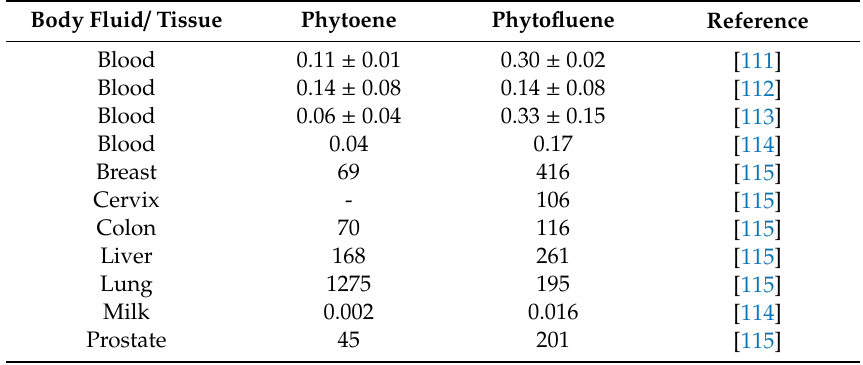
Table 3. Concentration of phytoene and phytofluene in body fluids ( µ M) and tissues (ng /